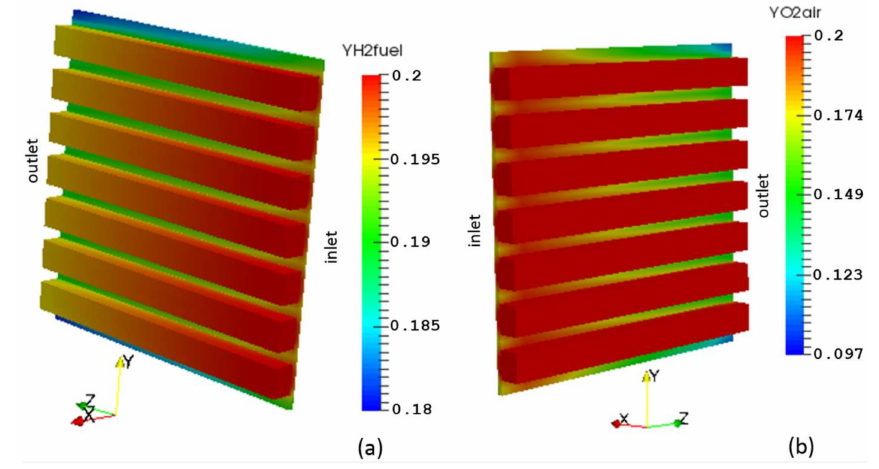
Figure 10. Species mass fraction distribution: ( a ) Hydrogen; ( b )